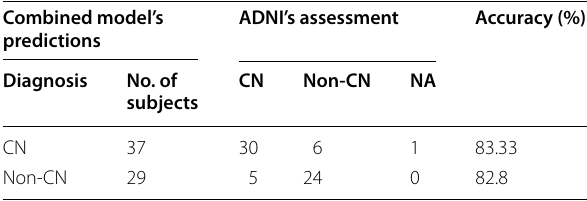
Table 7 Combined model’s prediction accuracy by category at